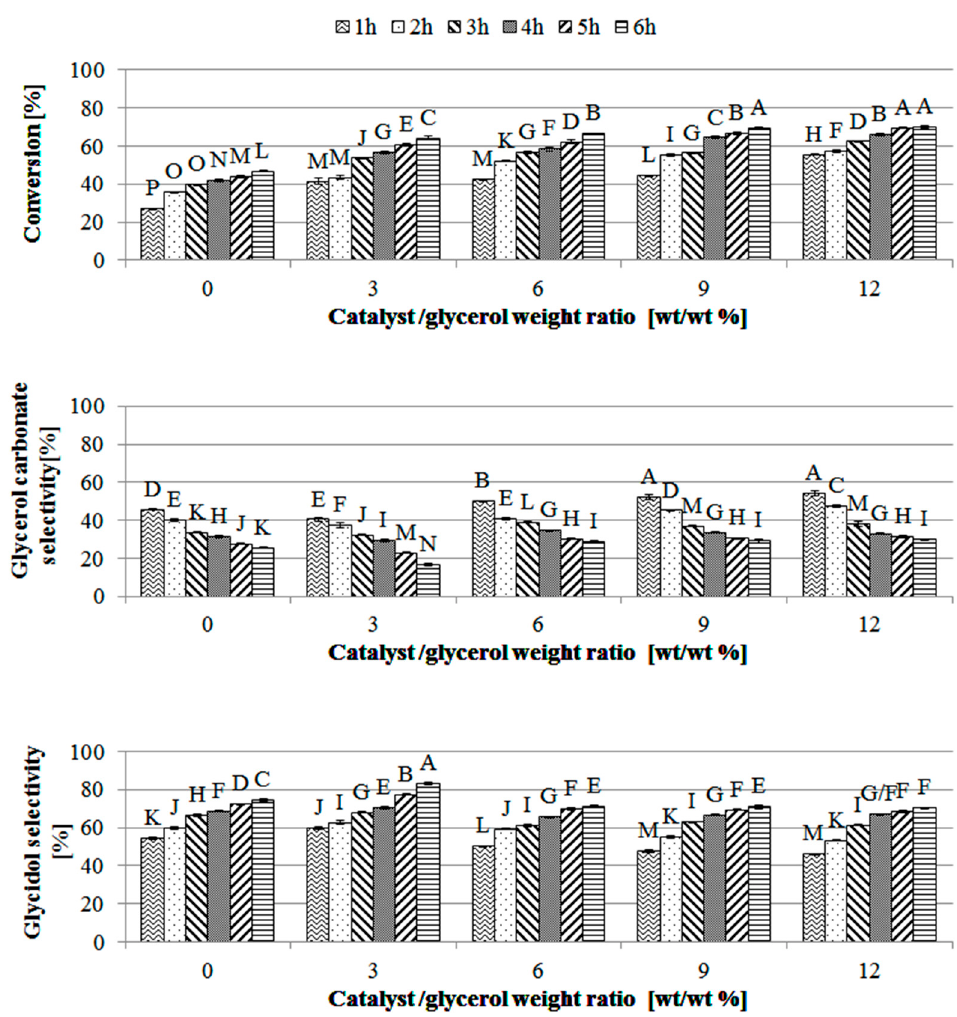
Figure 4. The influence of catalyst loading on the catalytic performance of a biosolids-based catalyst. Reactions were performed at 140 °C, with a 2:1 molar ratio of urea:glycerol, and the use of an air stream to promote the forward reaction. For these experiments, different catalyst:glycerol loading ratios (0 wt %, 3 wt %, 6 wt %, 9 wt %, 12 wt %) were examined. The means of triplicate experiments are reported, with the error bars representing standard deviations. Data annotated with different letters are significantly different (confidence level of 95%).